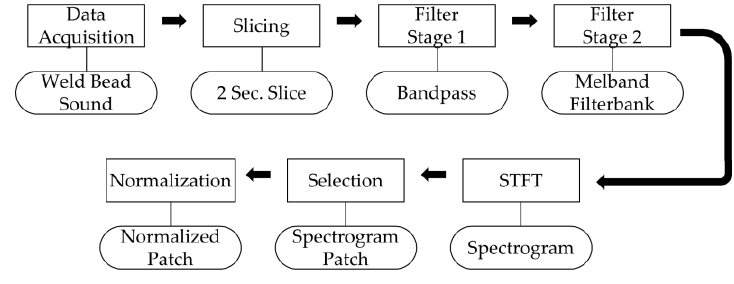
Figure 7. Data pipeline.